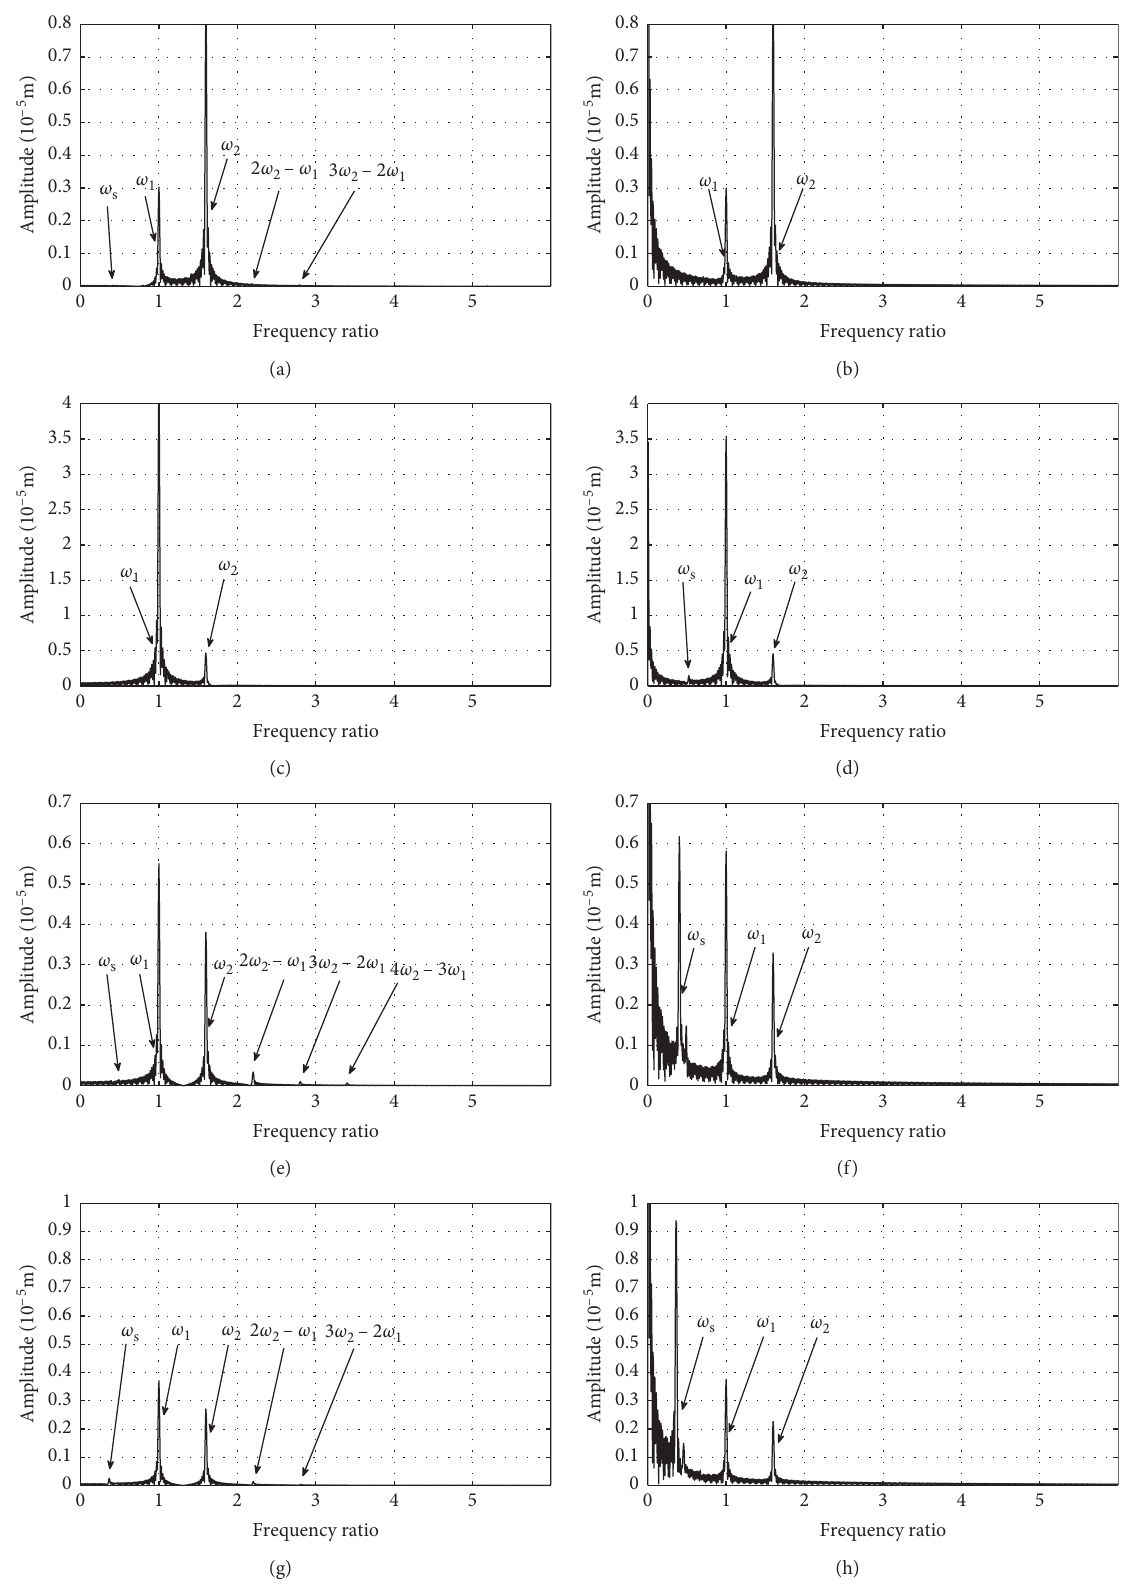
Figure 15: Spectrograms for the vertical vibration of disk 4. (a) 300rad/s, straight flight. (b) 300rad/s, hovering. (c) 400rad/s, straight flight. (d) 400rad/s, hovering. (e) 500rad/s, straight flight. (f) 500rad/s, hovering. (g) 550rad/s, straight flight. (h) 550rad/s,